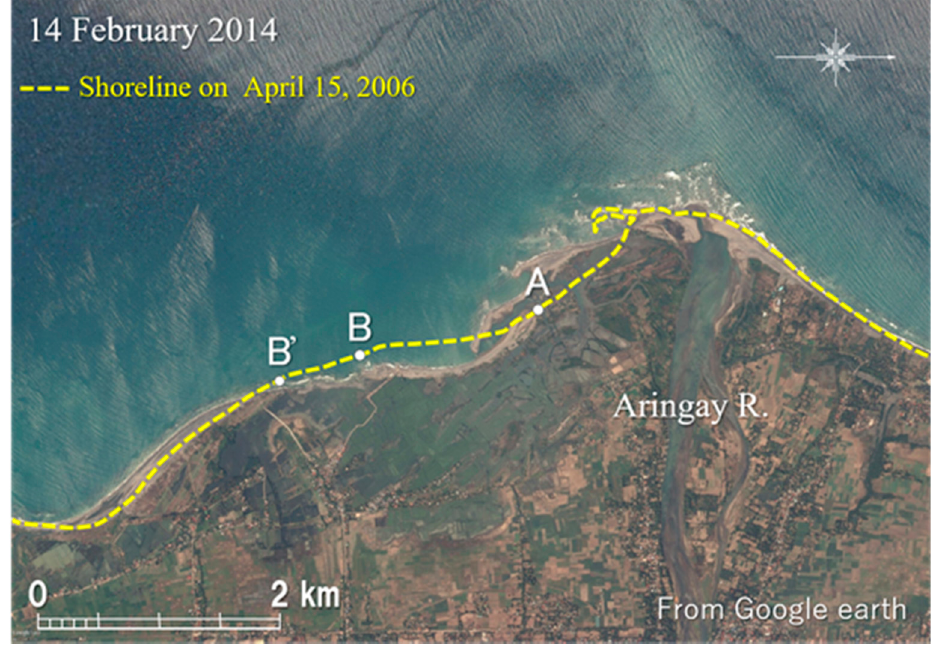
Figure 14. Satellite image of shoreline around Aringay River mouth (14 February 2014).